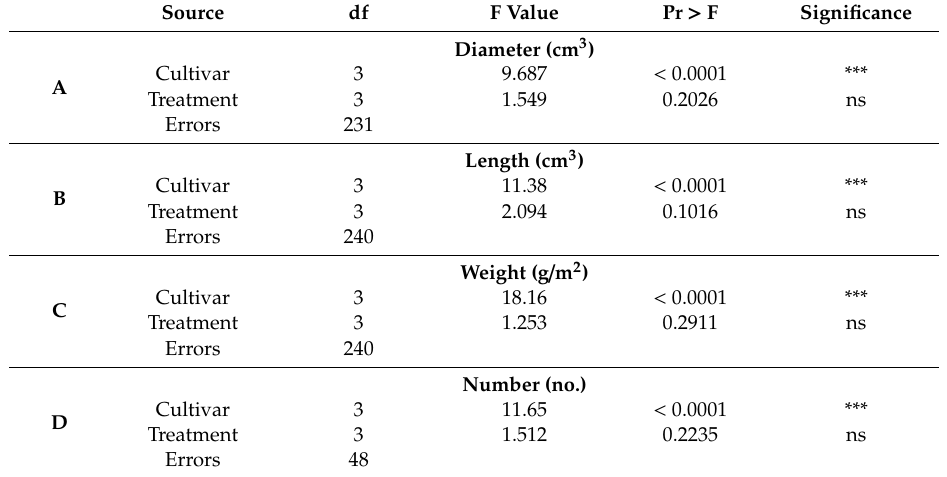
Table 3. ANOVA results for diameter, length, weight, and number of individual sweetpotato roots.